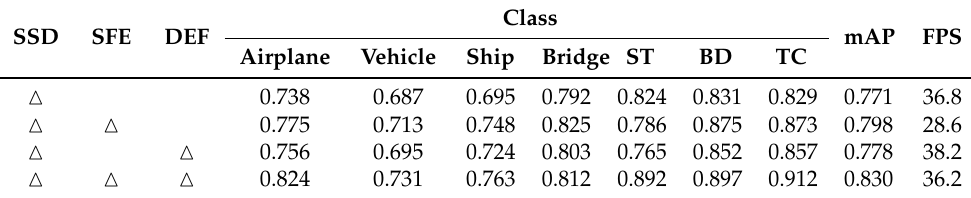
Table 5. The influence of feature enhancement module on target